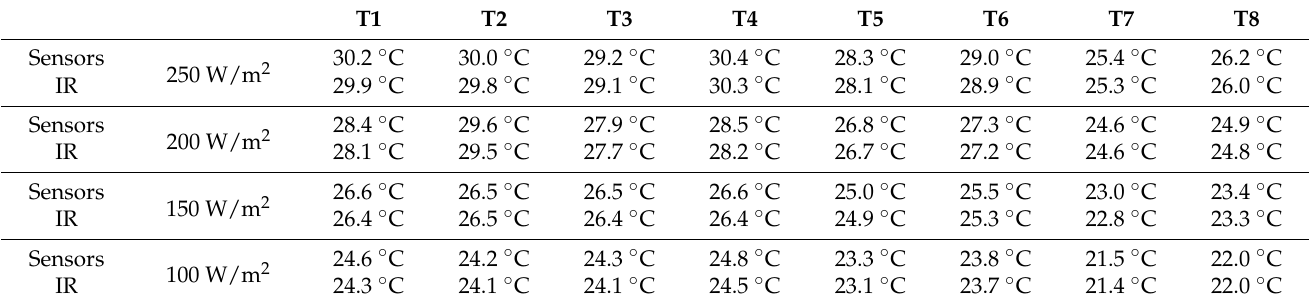
Table 6. Temperature comparison between experimental and infrared camera results for